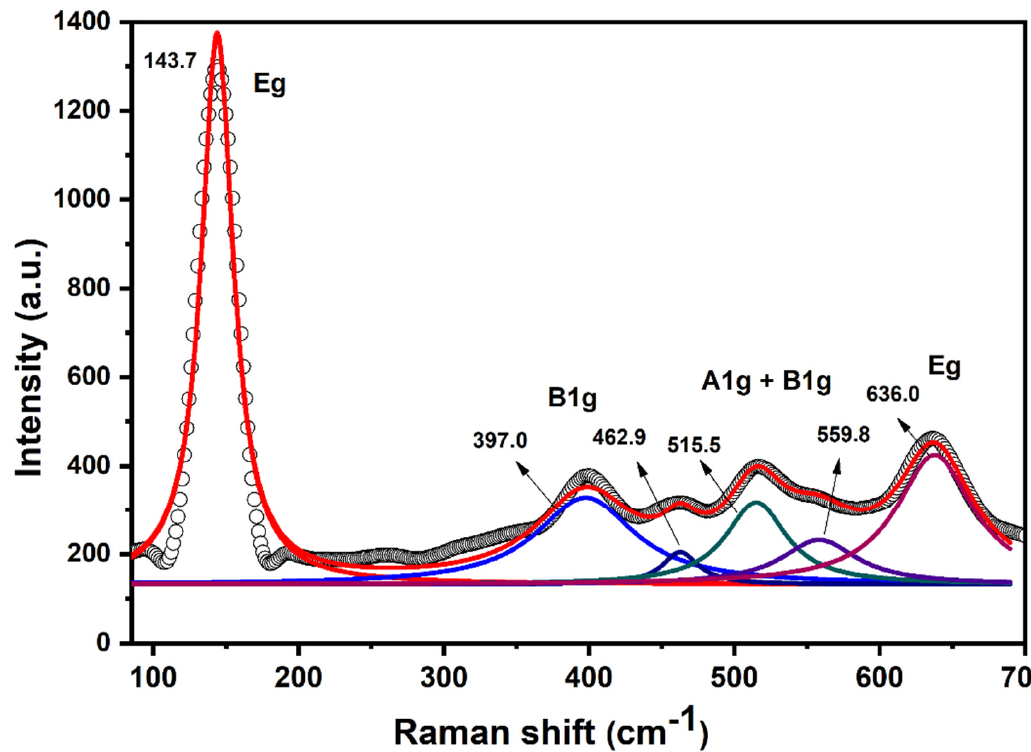
Figure 5. Raman spectroscopy of Titanium dioxide nanoparticles shows the intense and low intense E g modes appear at 144, 193 cm − 1 .